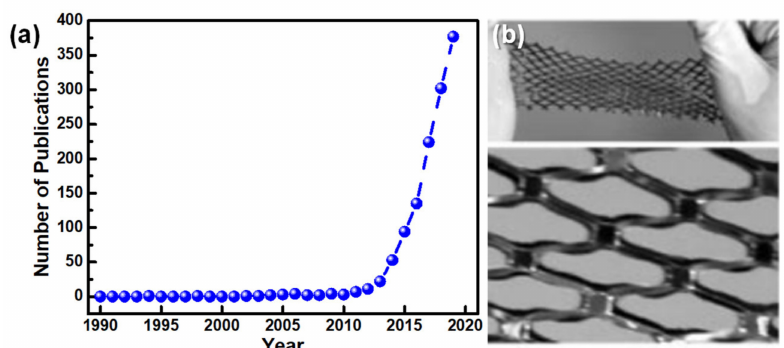
Figure 3. The beginning and growth of e-skin field. ( a ) Number of publications with the expression “electronic skin” on their content since 1990 (numbers estimated through Web of Science results). ( b ) E-skin developed by the group of Takayasu Sakurai in 2005 [29] [Copyright (2005) National Academy of Sciences,